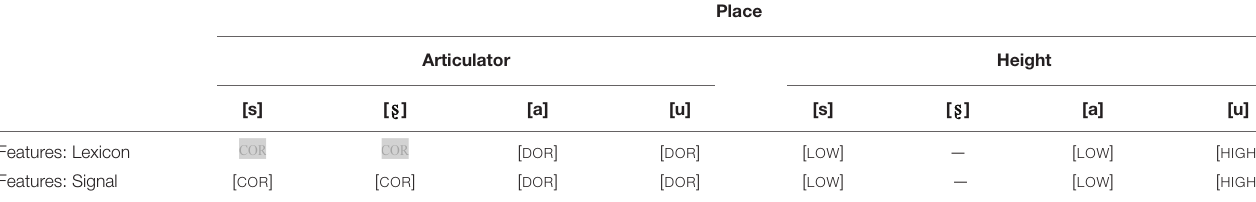
TABLE 2 | Critical features for the Mandarin CV